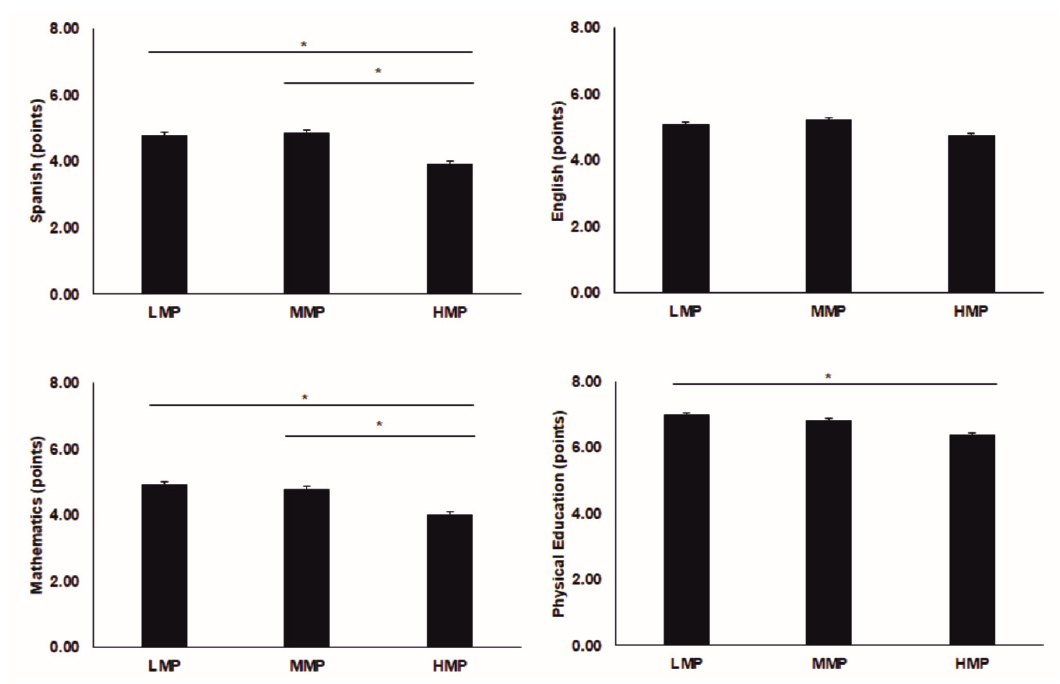
Figure 3. Results of academic performance. LMP = low use of the mobile phone; MMP = medium use of the mobile phone; HMP = high use of the mobile phone. * significant differences between groups; significant criteria p <